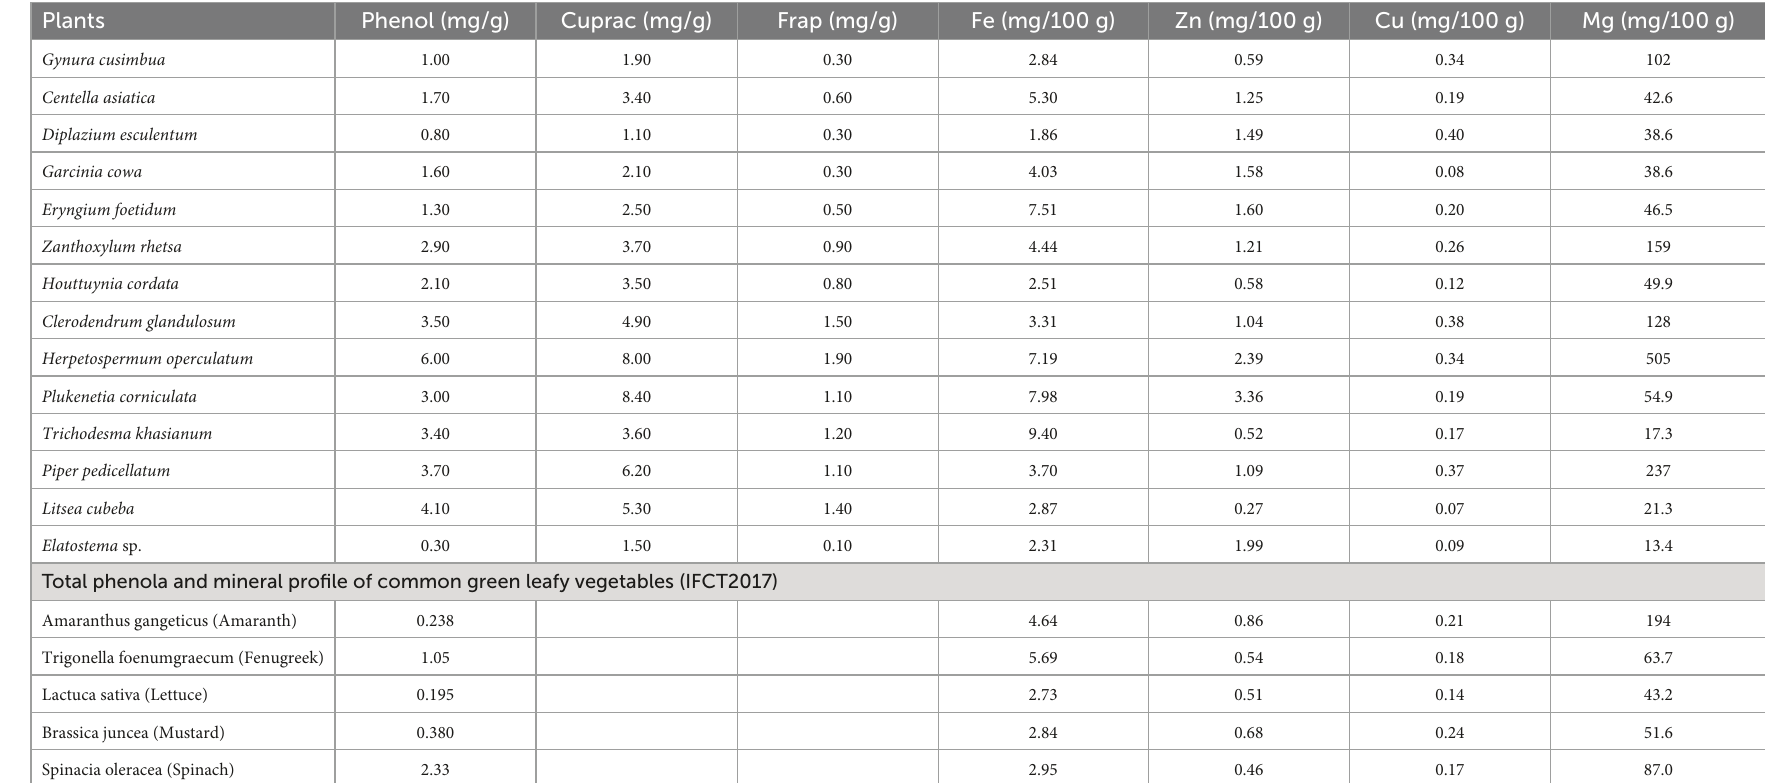
TABLE 3 Total antioxidant activity and mineral composition of wild edible plants of North Eastern region, India.